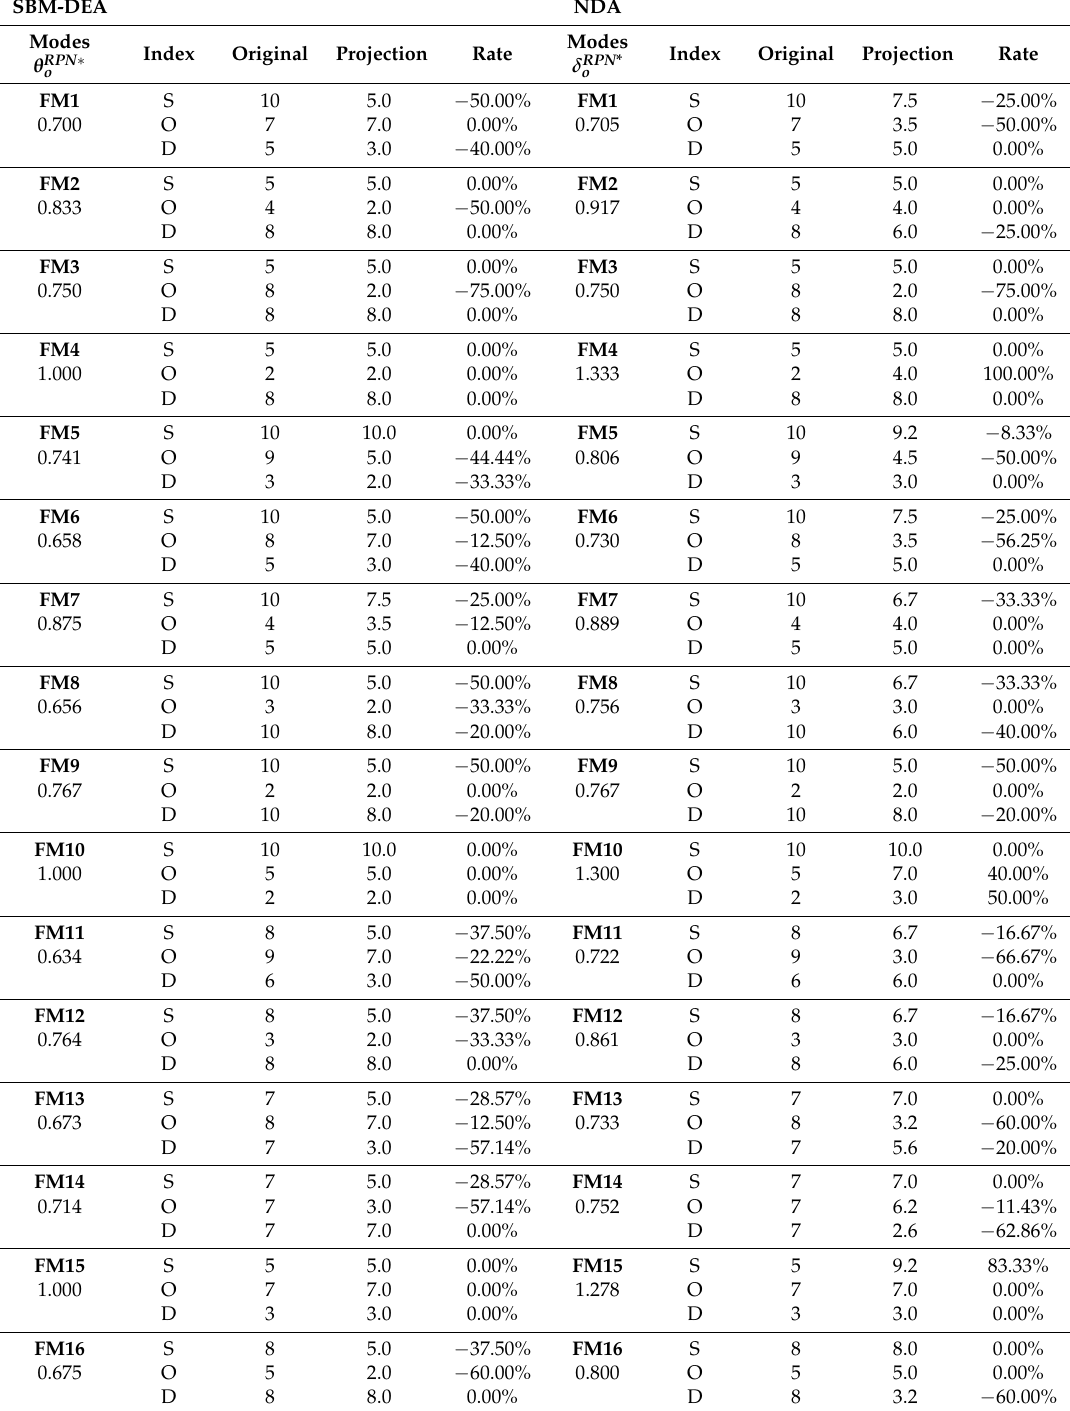
Table 2. Comparative results of SBM-DEA and novel data-driven approach